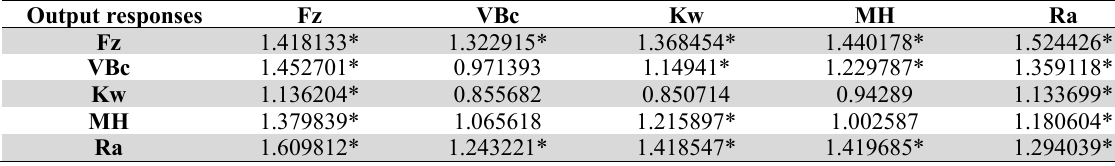
Total relational-matrix for the output responses